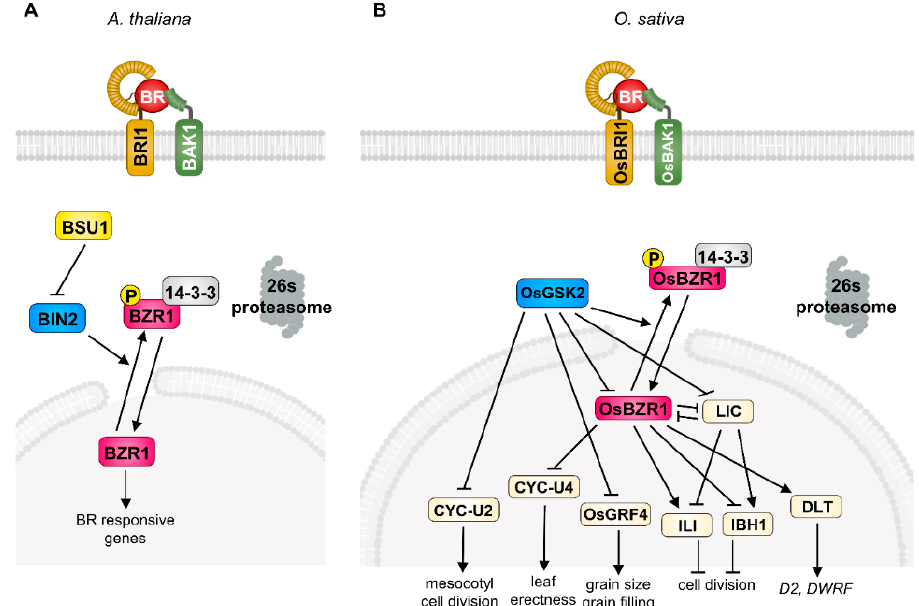
Figure 1. Brassinosteroid (BR) signaling pathways in Arabidopsis and rice. The simplified BR signaling cascade in Arabidopsis ( A ) and rice ( B ). BRI1 directly interacts with BR and forms the receptor protein complex with BAK1 which promotes the phosphorylation of BSU1 indirectly. Phosphorylated BSU1 inactivates the BIN2 and leads to nuclear accumulation of dephosphorylated BZR1 in Arabidopsis ( A ). The BR-OsBRI1-OsBAK1 complex inactivates the OsGSK2 which inactivates the BR signaling output regulators including OsBZR1, LIC, OsGRF4, and CYC-U2 in rice. De-phosphorylated OsBZR1 regulates the target components (CYC-U4;1, LIC, ILI, IBH1, and DLT) involved in primary BR response in rice ( B ).